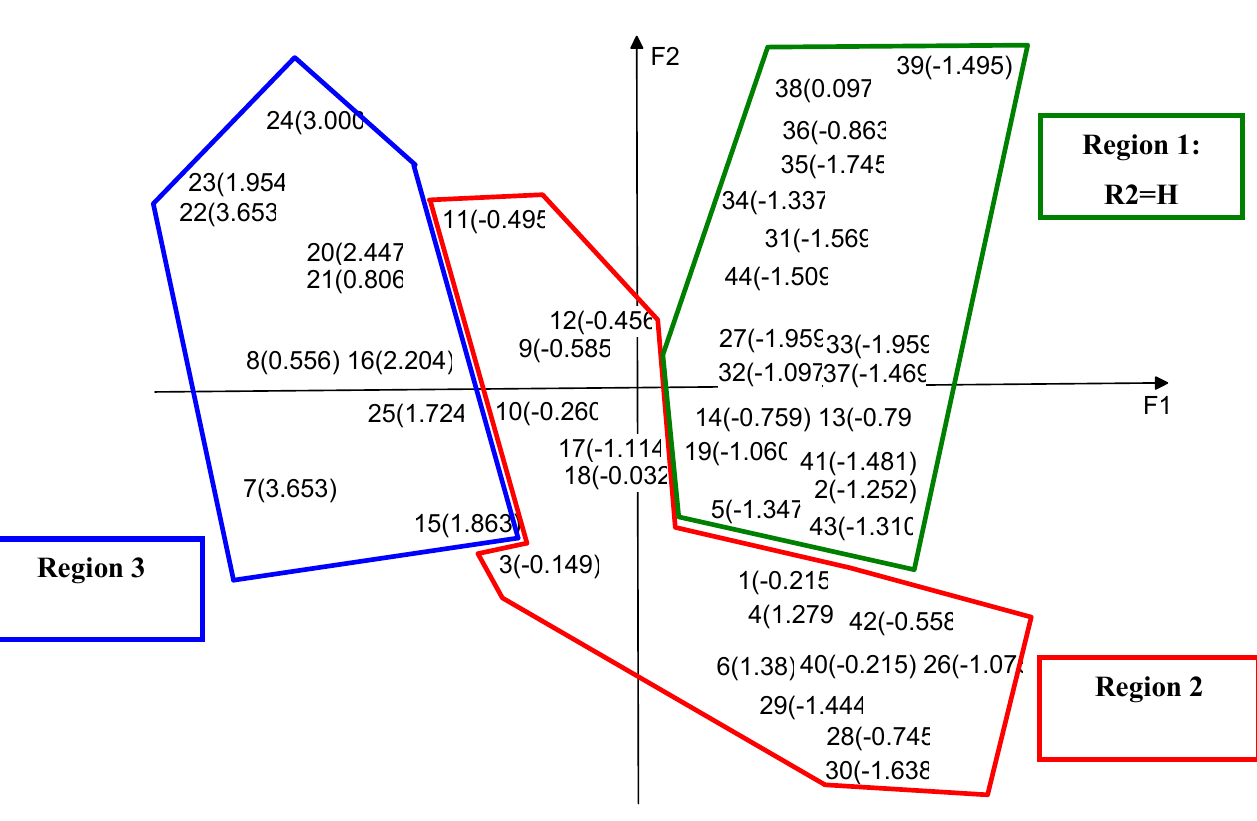
Figure 2. The graphic projection of the points representing MK801 derivatives on the first two principal components F1-F2. logKi is given into brackets. Region 1, contains compounds having higher logKi. Those having average ones are in region 2 and the lower ones are in region